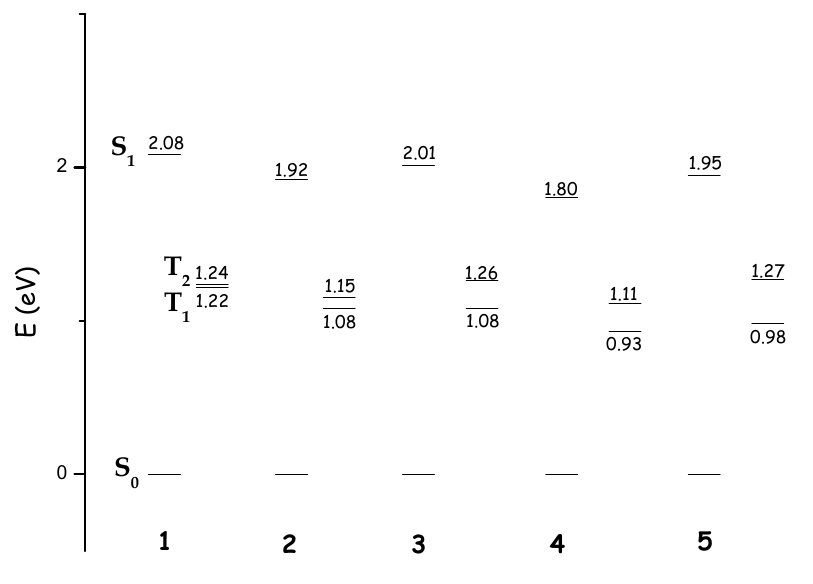
Figure 4. Lowest vertical singlet and triplets excitation energies (eV) of compounds 1 – 5 computed in dichloromethane at TD-B3LYP/cc-pVDZ level of theory.